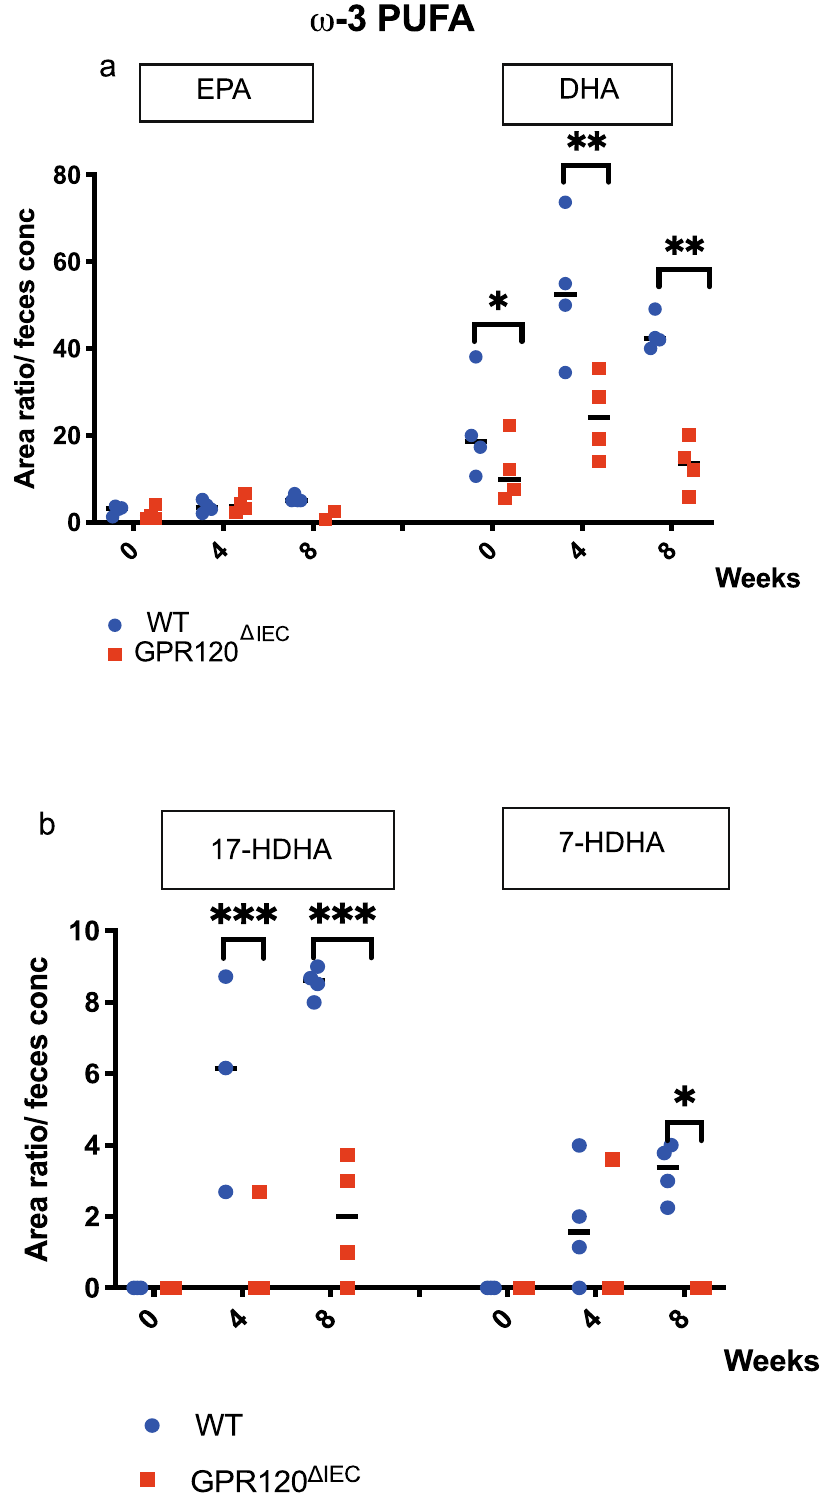
Figure 6. The loss of epithelial GPR120 impacts on fecal lipids metabolites. ( a,b ) ω-3 PUFAs ( a ) and DHA- derived metabolites ( b ) were quantified through LC–MS/MS analysis and expressed as area ratio/feces concentration. Values are expressed as median ± 95% CI. *p.value < 0.05; **p.value < 0.001; ****p.value < 0.00005 by Mann Whitney